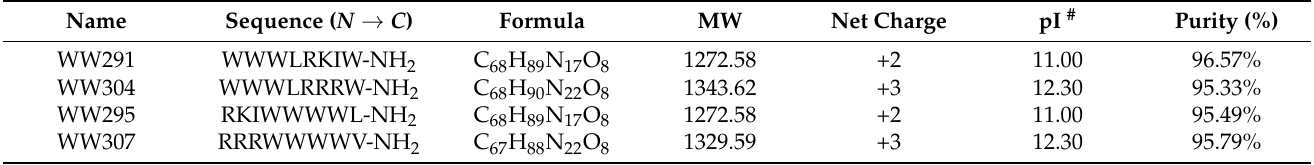
Table 1. Key physicochemical parameters of amphipathic